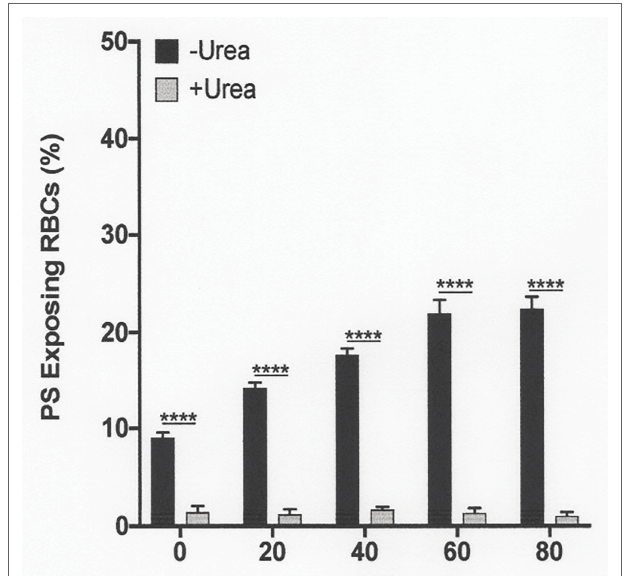
FIGURE 7 | The effect urea on phosphatidylserine exposure at pH 7.0 in deoxygenated red cells from patients with SCA. Red cells (1% Hct) were incubated in Eschweiler tonometers at 37 o C, pH 7.0 and an osmolality of 290 mOsm.kg-1 for up to 80 min under fully deoxygenated (0 mmHg oxygen) conditions in the absence of urea (-Urea) or in its presence (+Urea, 600 mM). At the time intervals indicated, red cell aliquots were removed and PS exposure measured using LA-FITC, as described in the Methods. Symbols represent means ± SEM, n = 3. **** p < 0.0001, comparing red cells in the absence of urea with those in its